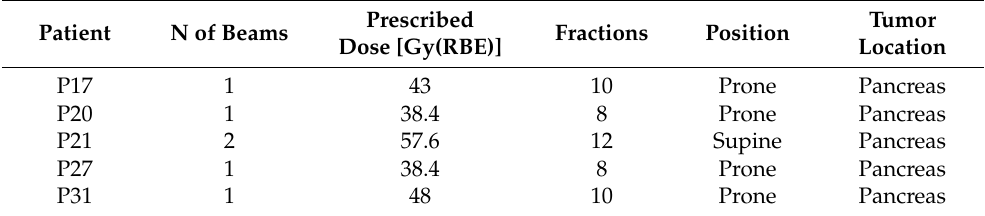
Table 1. CIRT plan details for the patients used in the test